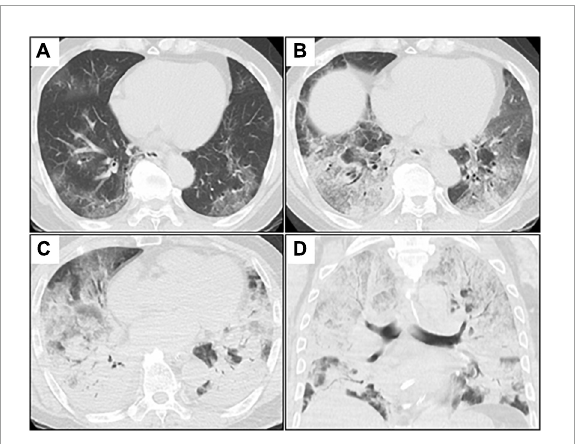
FIGURE1 Serial chest CT images after admission. (A–C) , axial images; (D) , coronal image. (A) Initial chest CT shows patchy GGOs in bilateral peripheral lungs. (B) Chest CT on day 3 (day 3 of admission) shows extensive and diffuse GGOs with patchy consolidation. (C,D) Chest CT on day 7 shows diffuse consolidations worsening from GGOs with air bronchogram in both the lungs. CT, computed tomography; GGOs, ground-glass opacities.